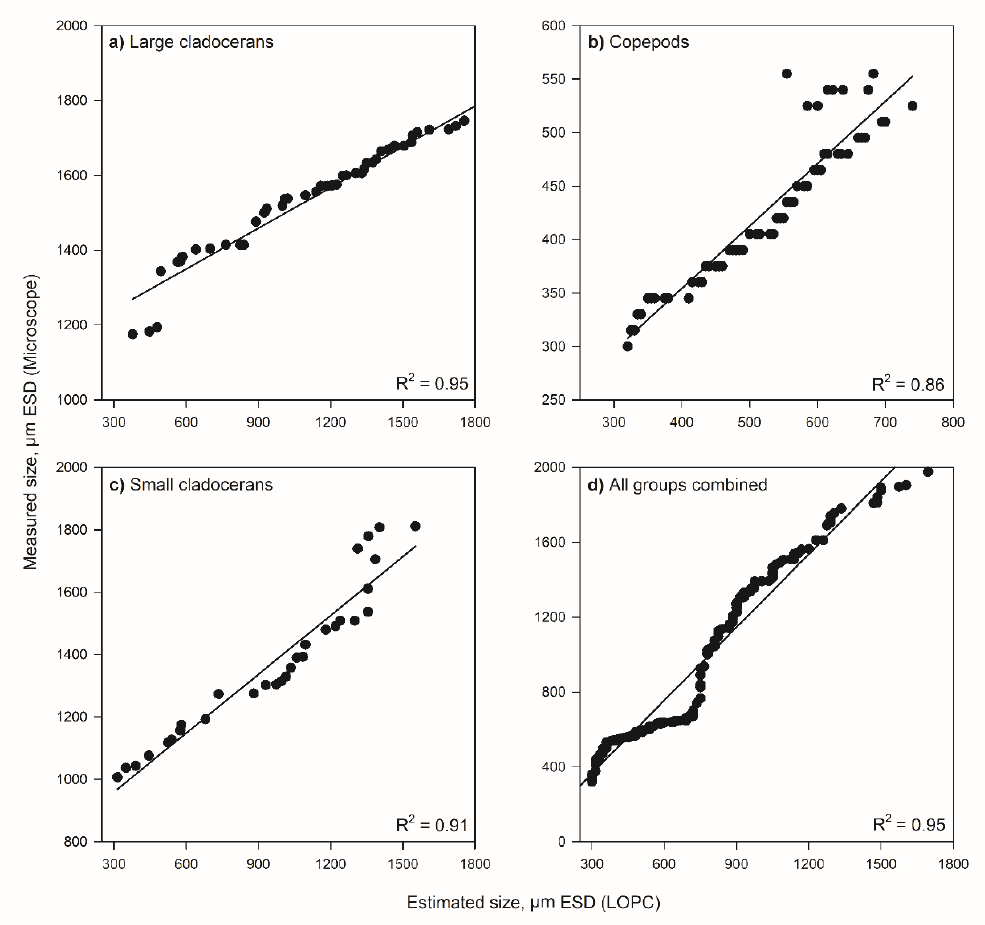
Figure 3. Comparison between Laser Optical Plankton Counter (LOPC) estimated size and calcu-